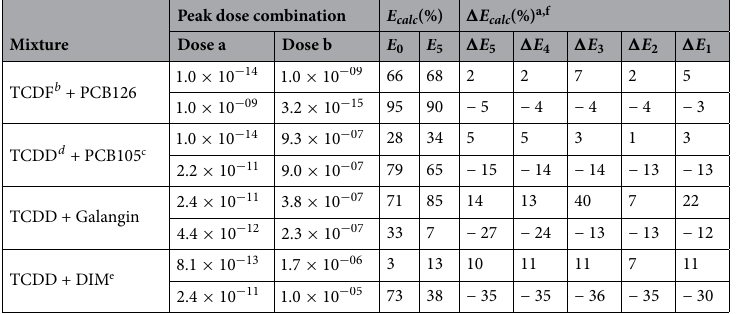
Table 5. Minima and maxima of synergy surfaces: peak synergism/antagonism for AhR agonists. a Peak- difference between calculated full-( E 5 ) and null-interaction ( E 0 ) responses at the respective dose-combinations of E 5 (corresponding dose combinations not shown for the E 1 to E 4 surfaces). Subscripts denote the parameter sets from Table 4. b − e See legends of Table 3. f Values of ≈ 15 ≥ (cid:31) E ≥ − ≈ 15 are assumed to be within the exptl.